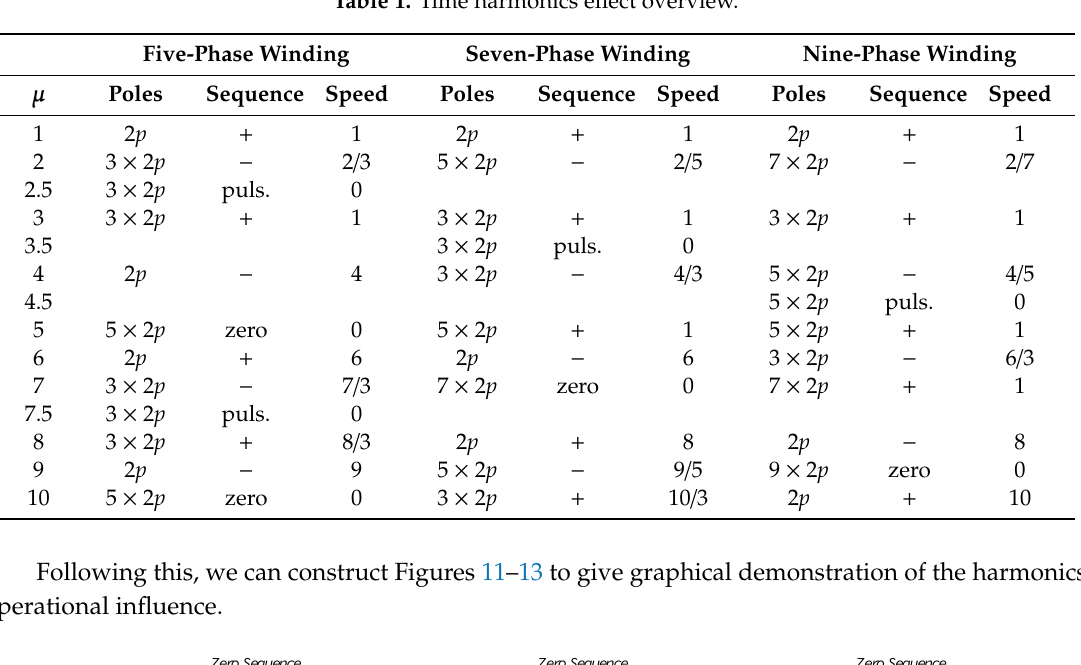
Table 1. Time harmonics e ff ect overview.